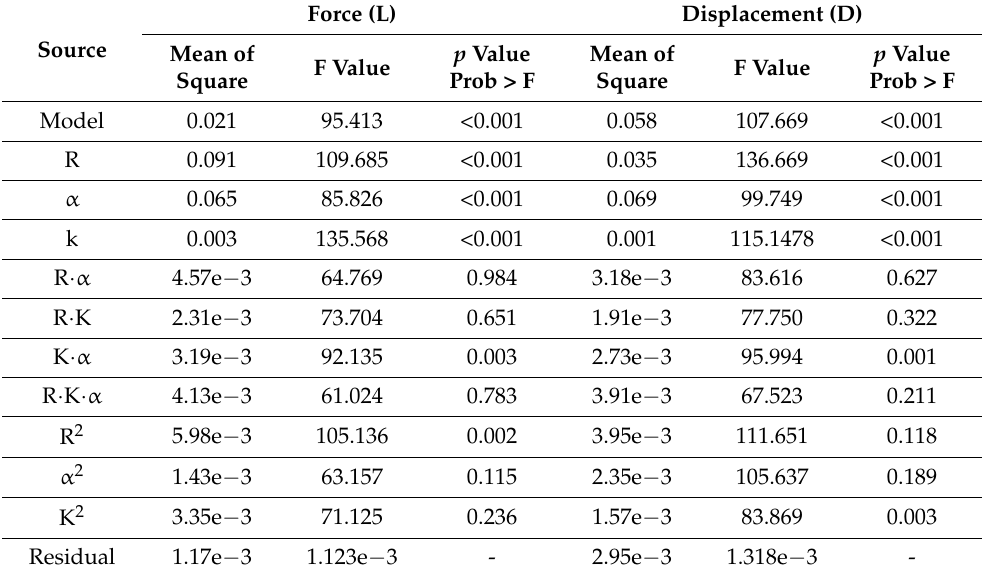
Table 5. ANOVA analysis for force (L) and displacement (D), in response to the variations of parameters R, K, and α for new